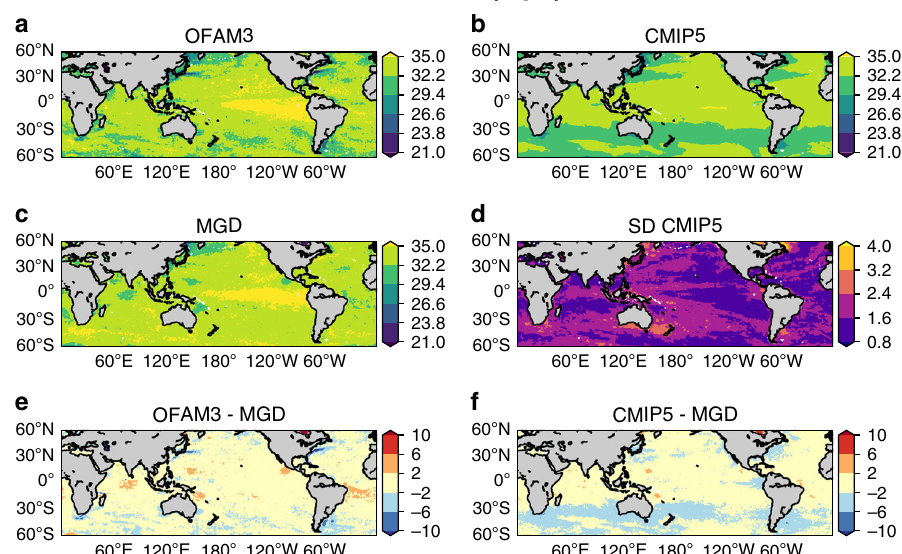
Fig. 1 Historical annual marine heatwave days. Spatial distributions of annual marine heatwave (MHW) days averaged over 1982 – 2018 based on a a high- resolution ocean model (OFAM3), b the multi-model mean product of 23 global climate models (CMIP5), and c observations (MGD). d Inter-model spread of the CMIP5 models, as determined by standard deviations. Biases in e OFAM3 and f the CMIP5 multi-model mean product, as determined by their difference from